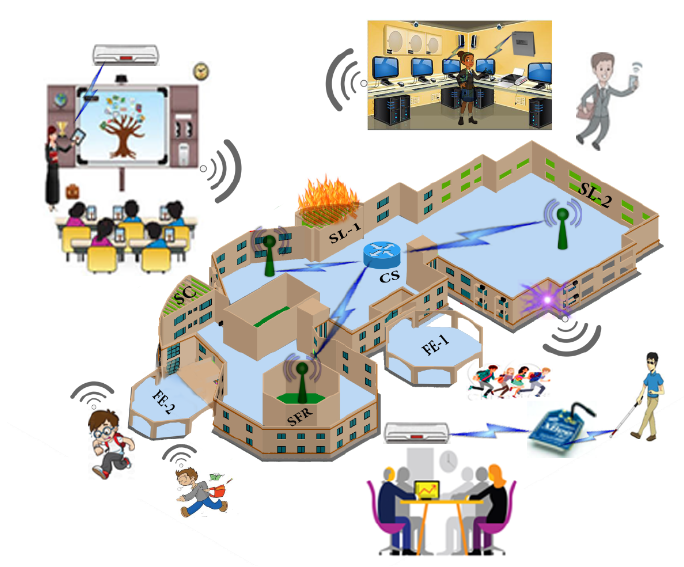
Figure 3. IoT Based SC.